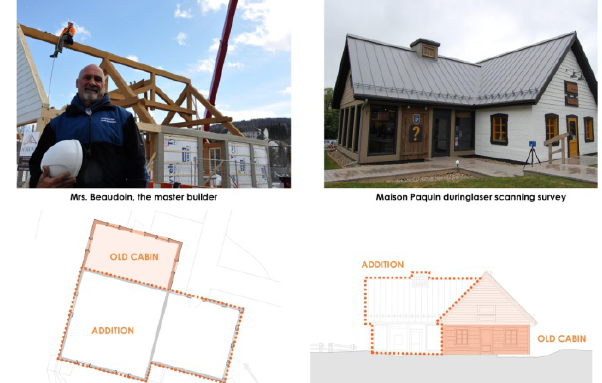
Figure 2. Maison Paquin